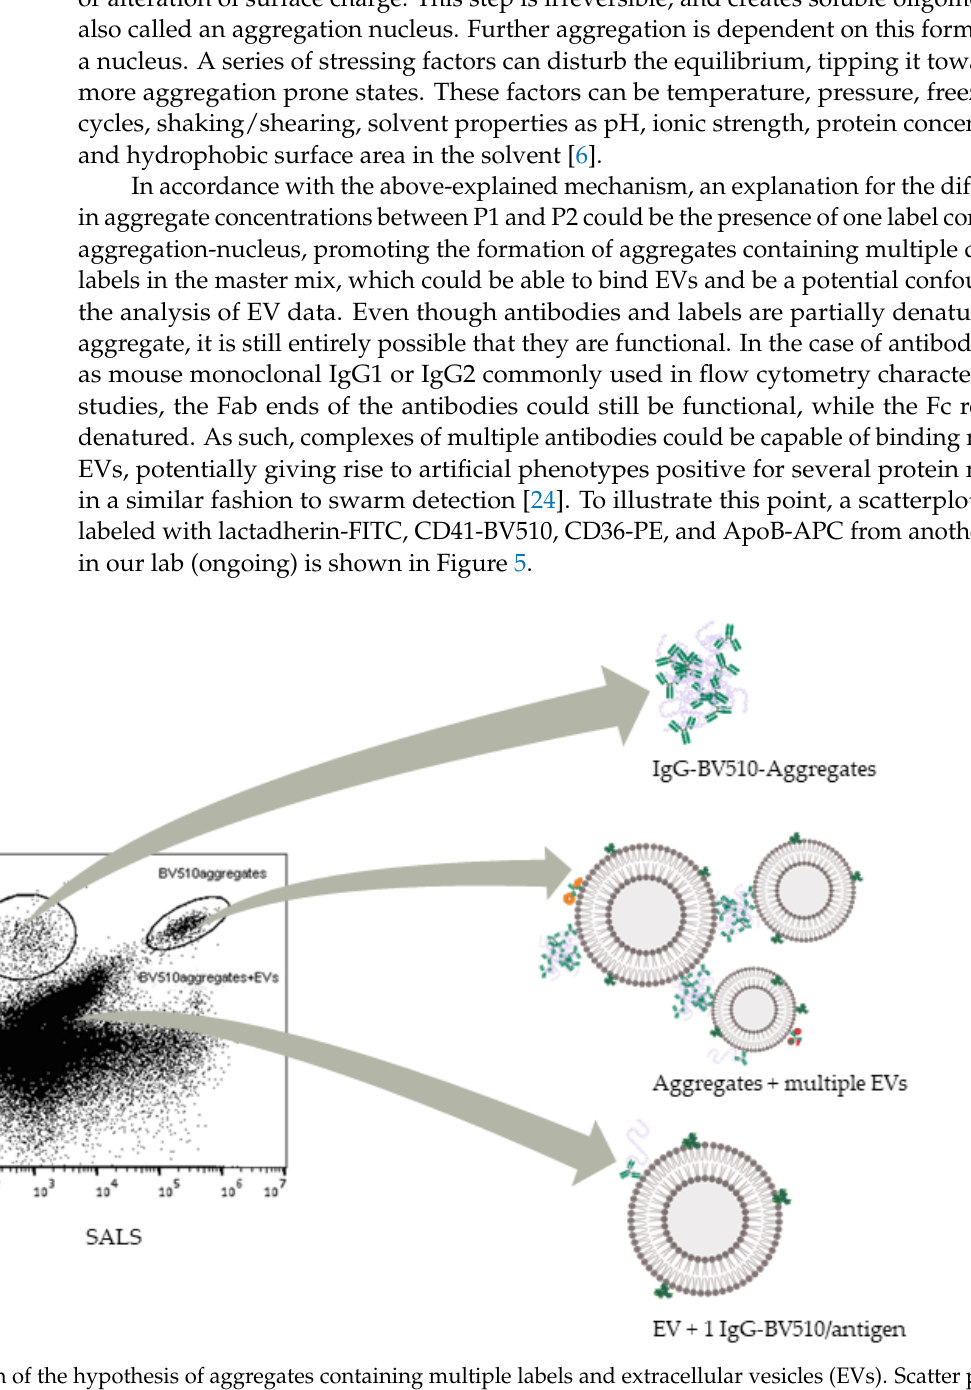
Figure 5. Illustration of the hypothesis of aggregates containing multiple labels and extracellular vesicles (EVs). Scatter plot of PPP labeled with lactadherin-FITC, CD41-BV510, CD36-PE, and ApoB-APC. Schematic representation of the different labels is shown in Table S3.